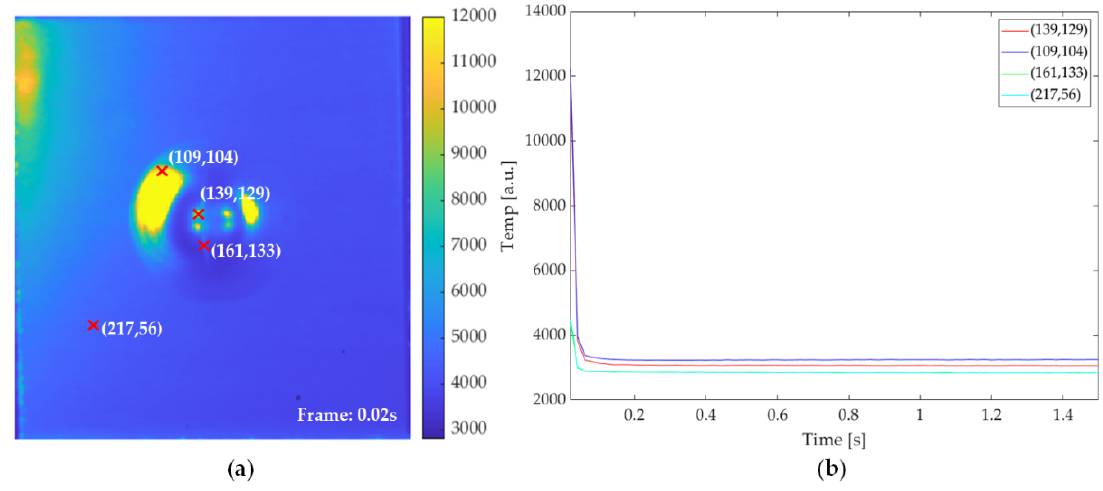
Figure 6. PT result on Al_G_60J sample: ( a ) pseudo color image of the first frame of the cooling stage; ( b ) temperature profile curve of the selected points.